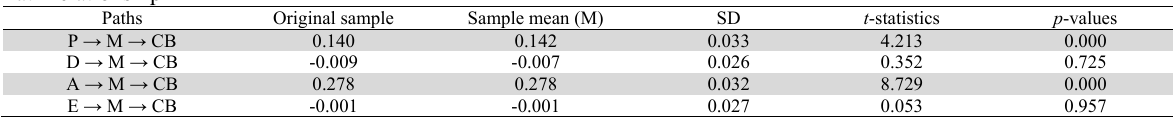
Path relationship